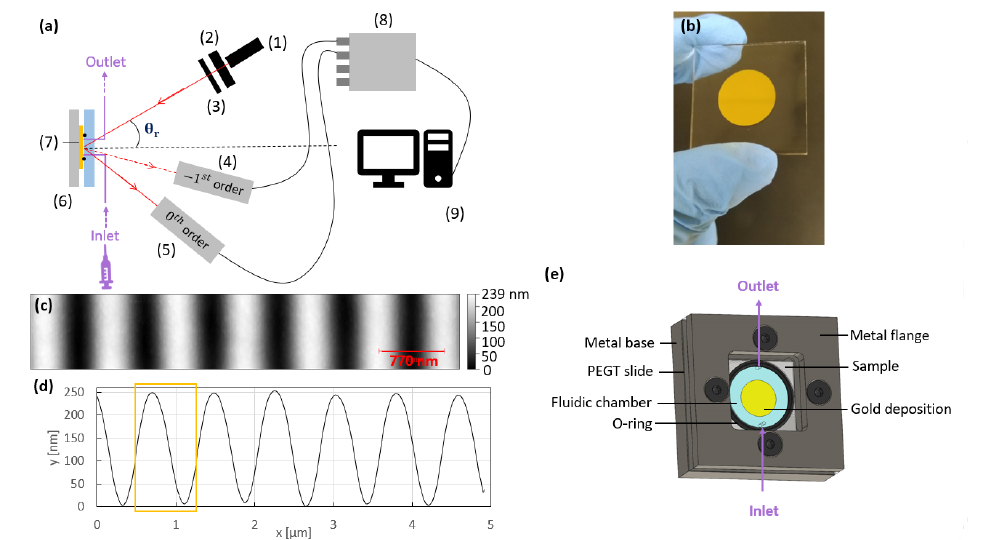
Figure 1. ( a ) Setup used to perform the measurements, comprising an 850 nm wavelength laser diode (1), a polarizer (2), an aperture (3), and two photodiodes (4) and (5) to measure the power in the − 1st (dashed red line) and the 0th (solid red line) orders diffracted from the gold-coated grating (6) placed within a fluidic cell (7) into which fluids are injected via peek tubing interfaces (purple) connected to a syringe pump. A DAQ (data acquisition) device (8) and a computer (9) were used to record the measurements. ( b ) Picture of the gold-coated grating sample on a 26 × 26 mm 2 glass slide. The sample consists of a sinusoidal grating replicated in amonil covered by a thin chromium layer and a 121 nm-thick gold layer. ( c ) Partial 2D AFM scan of the corrugated gold-coated grating replica used to perform the measurements. ( d ) AFM profile of the corrugated gold-coated grating replica used to perform the measurements. ( e ) Schematic of the sensor (item (6) in Part ( a )) showing the fluidic inlet and